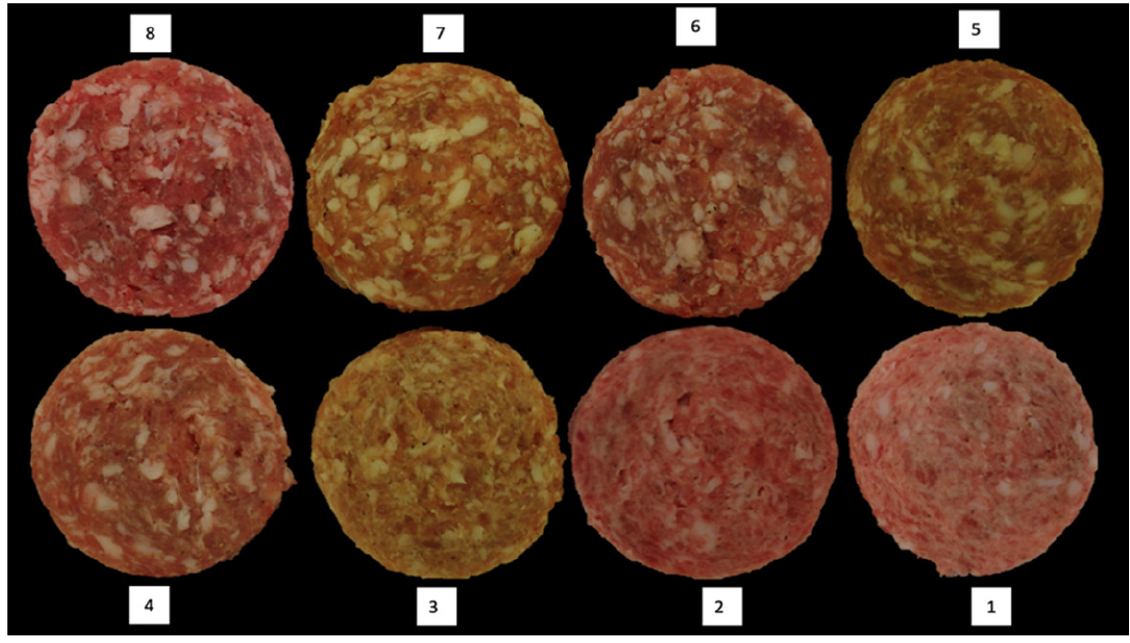
Figure 3. Sausage fat smearing score used to score each sausage patty, with 1 displaying excessive fat smearing and 8 displaying very little fat smearing.